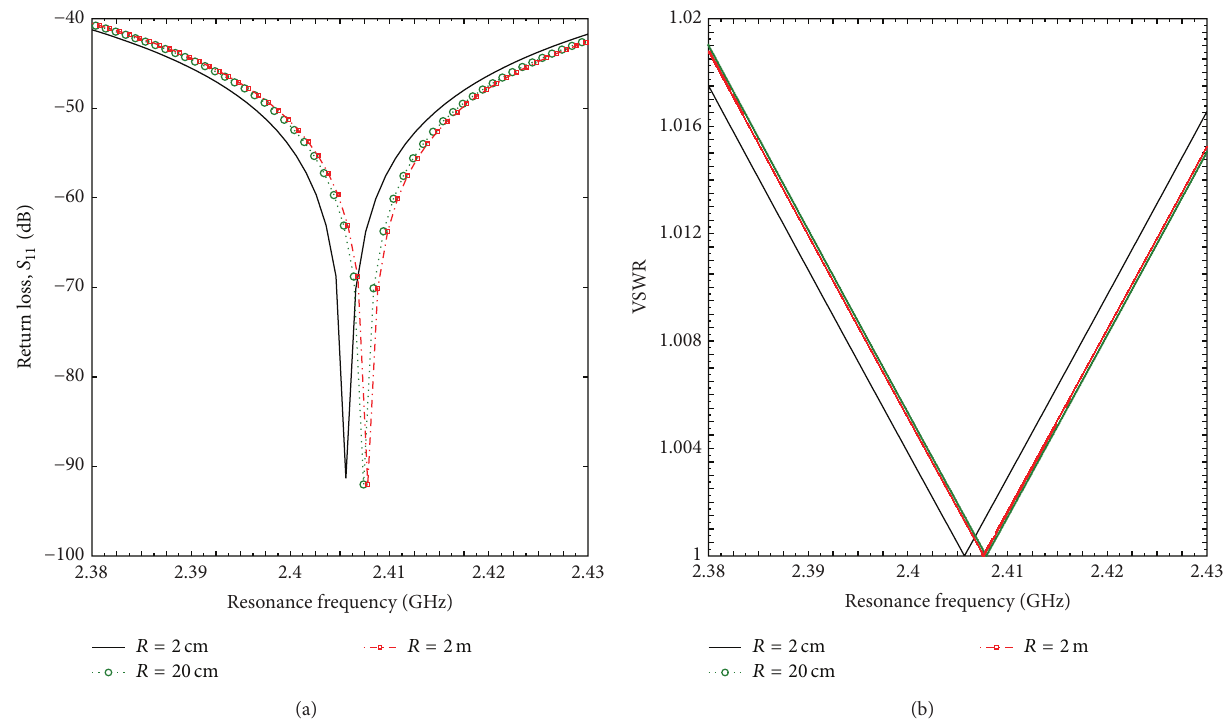
Figure 3: Impact of changing radius of curvature (2cm, 20 cm, and 2 m) of a circular microstrip patch (a) on the return loss in dB and (b) on the VSWR as a function of frequency. “Teflon substrate.”